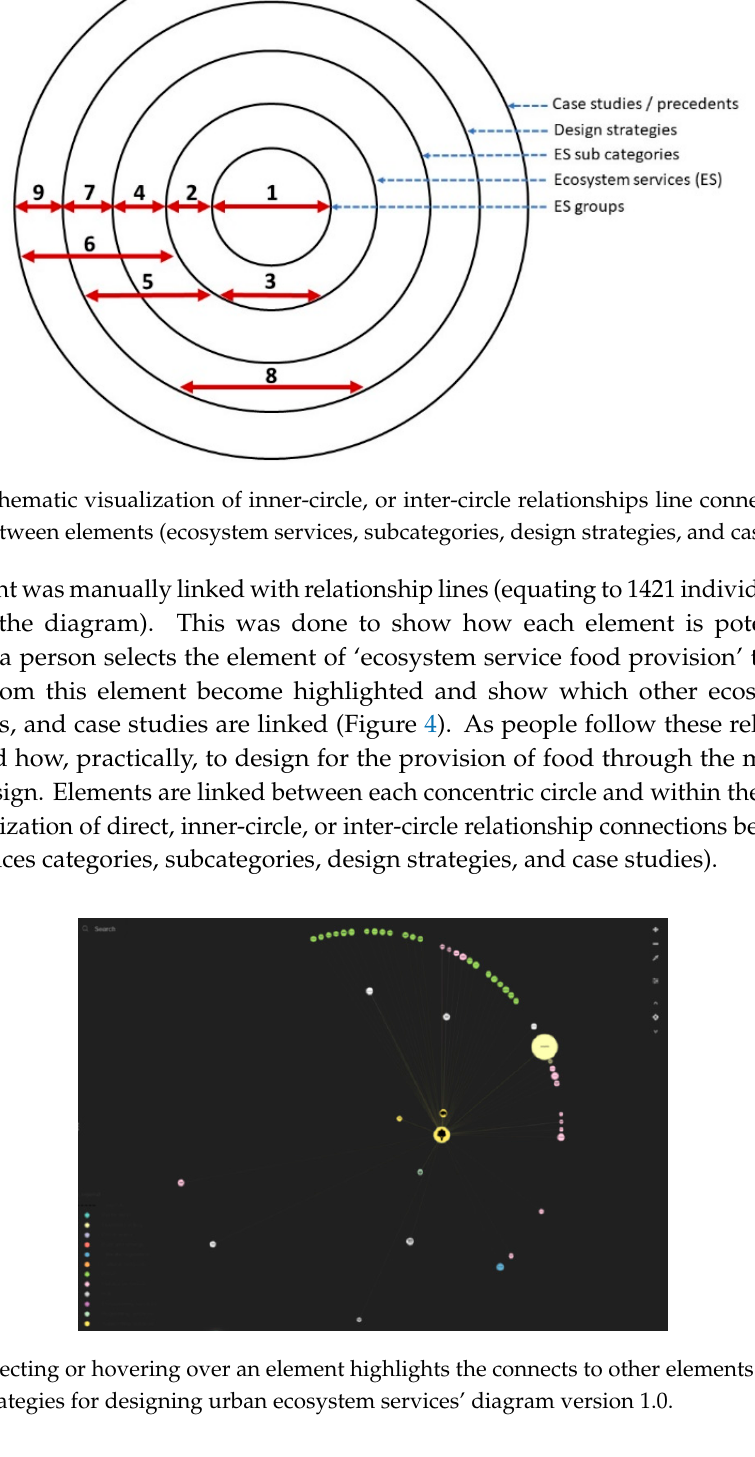
Figure 2. Screenshot of the ‘strategies for designing urban ecosystem services’ diagram version 1.0.